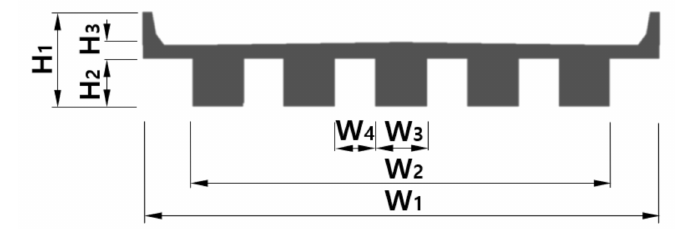
Figure 11. Design parameters for a T-type girder